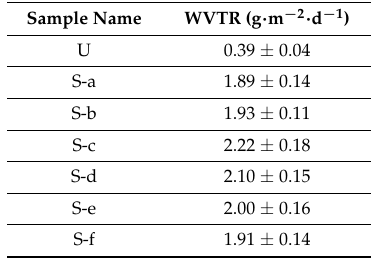
Table 3. Effect of self-assembled monolayer (SAM) reaction conditions on the water vapor transmission rate (WVTR) of the films.